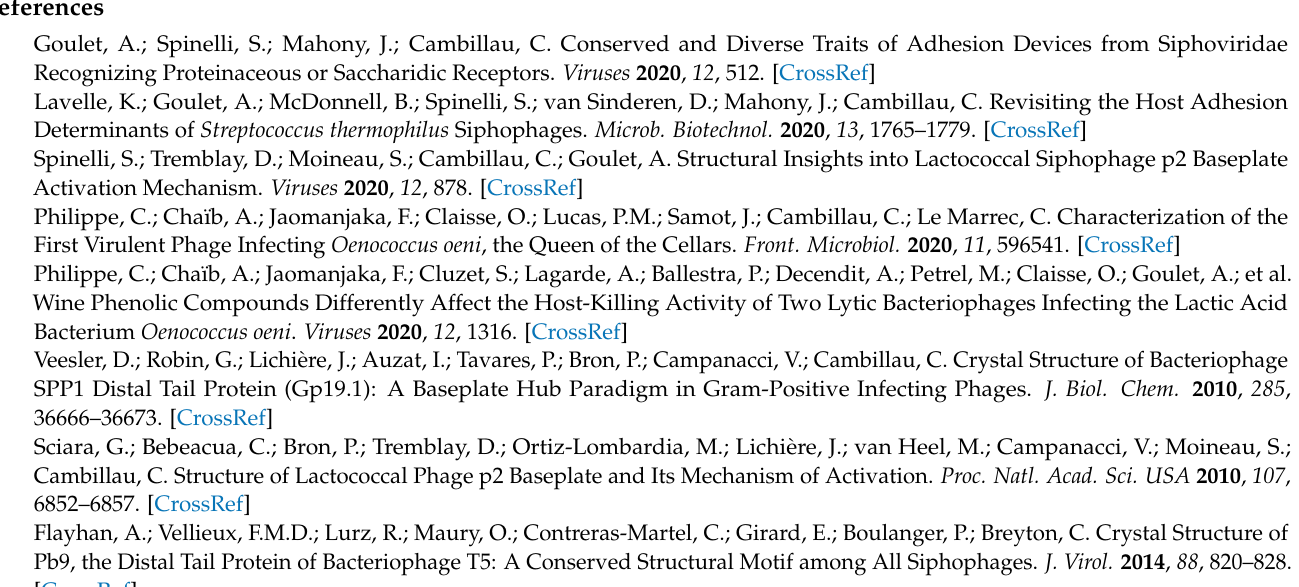
Figure S2: AlphaFold2 structure prediction of the OE33PA full-length Dit. Figure S3: AlphaFold2 confidence measures for OE33PA Dit domains, Tal, and RBP. Figure S4: AlphaFold2 confidence measures for Vinitor162 Dit and Tal domains. Table S1: Comparison of domain predictions by HHpred and